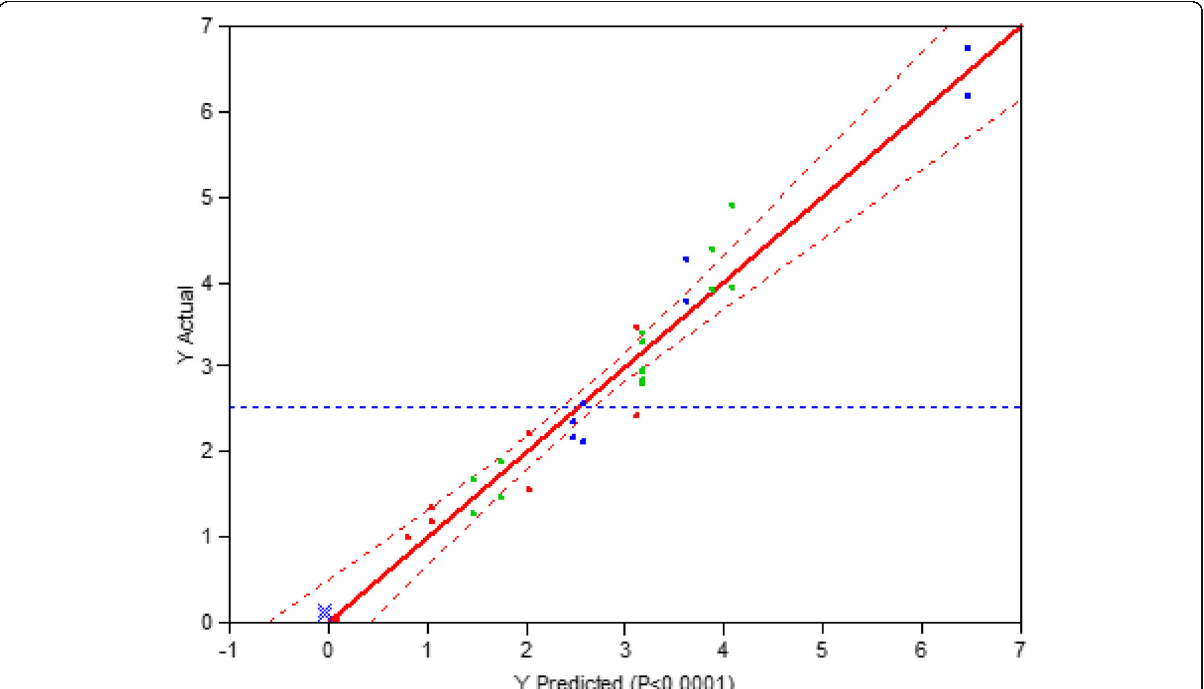
Fig. 4 Parity plot of actual response values and predicted response values; Y: response (the degree of